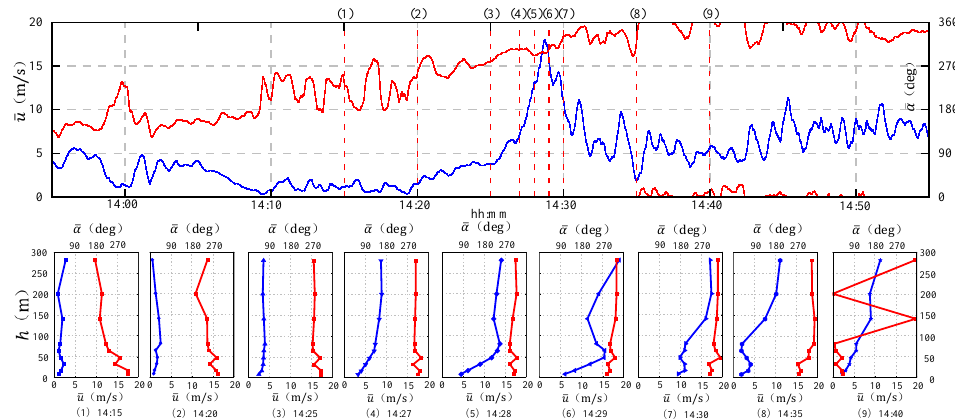
Figure 9. Spatial–temporal variation of slowly-varying mean wind speed (blue) and direction (red) at some significant instants.